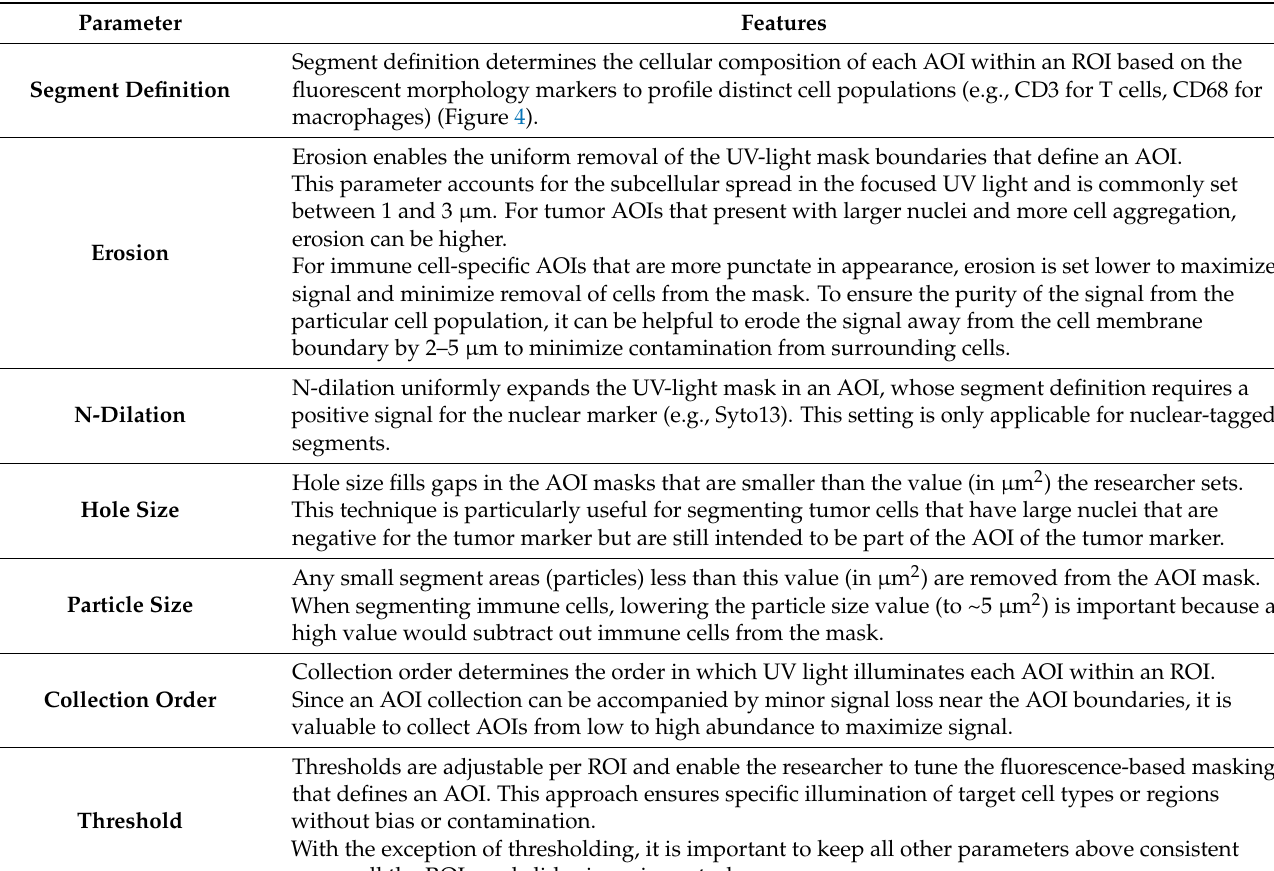
Table 2. Key adjustable parameters for AOI selection and